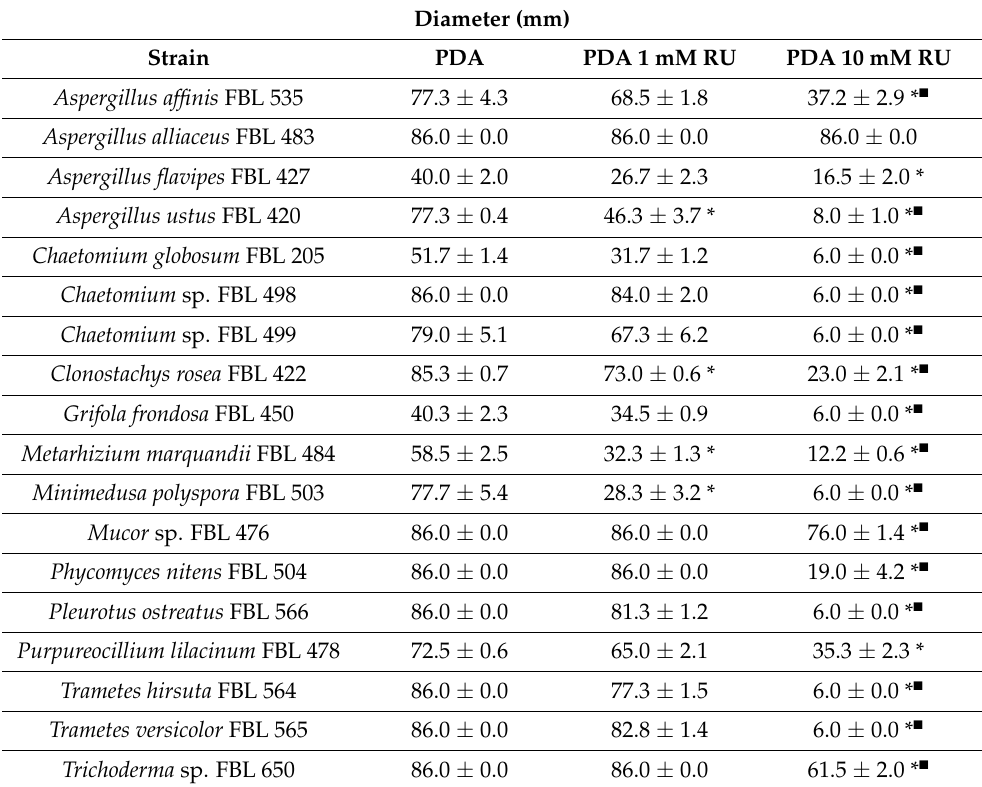
Table 2. Diametric values of fungal colonies after fourteen days of growth exposed to Roundup (RU) on Potato Dextrose Agar (PDA) at 25 ◦ C. The data are expressed as the mean ± standard error of independent biological replicates a